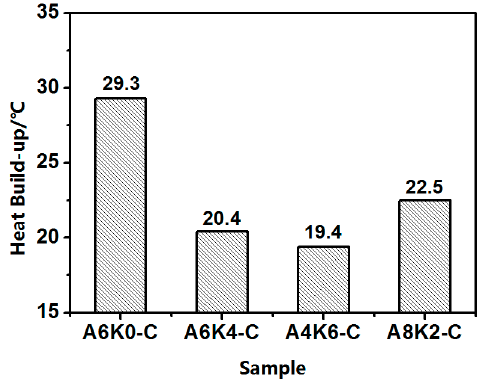
Figure 14. Heat build-up of four silica/NR composites.